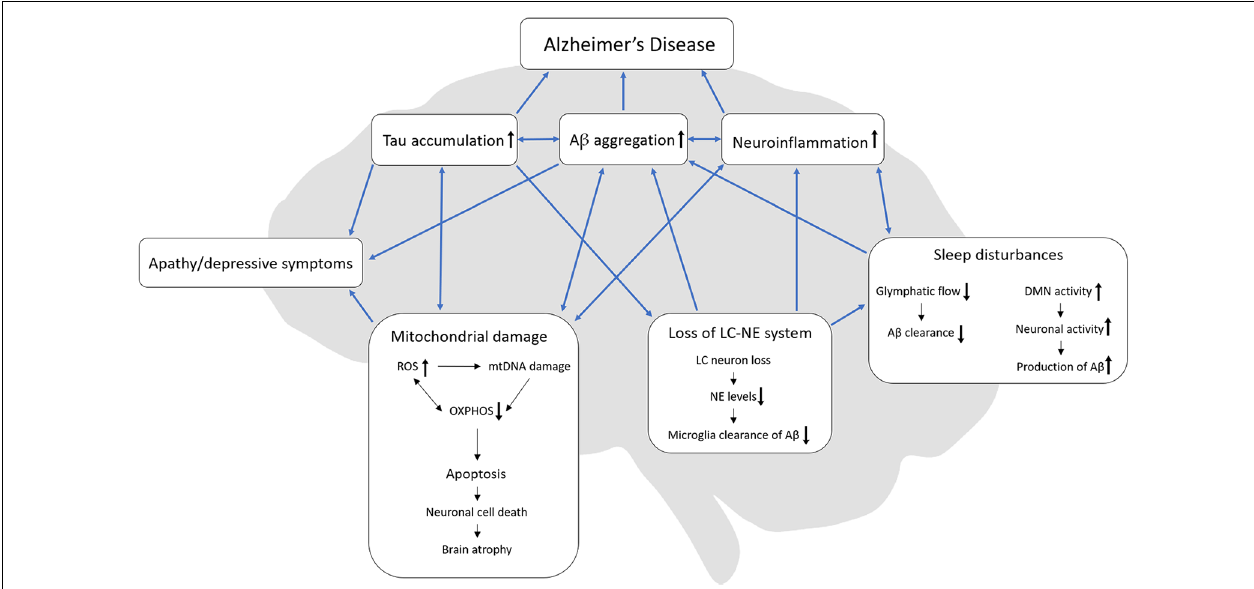
FIGURE 1 | Interactions of AD-related pathologies, apathy, depressive symptoms, and sleep disturbances. We hypothesize, that loss of the LC-NE system might originate from tau accumulation in the LC which in turn can cause sleep disturbances. In turn, sleep disturbances can reduce the glymphatic flow and thereby decrease A β clearance. Also, sleep disturbances might increase the DMN activity due to the lack of sleep which then increases neuronal activity with a resulting increase in A β production. Both loss of the LC-NE system and sleep disturbances can increase neuroinflammation. During mitochondrial damage, ROS increases and can cause damage to both mtDNA and OXPHOS but ineffective OXPHOS can also increase the production of ROS. Mitochondrial damage can ultimately lead to apoptosis, neuronal cell death and lastly brain atrophy, which is present in late-stage AD. Both tau accumulation, A β aggregation and mitochondrial damage can lead to apathy/depressive behavior. AD, Alzheimer’s disease; A β , beta-amyloid; ROS, reactive oxygen species, OXPHOS, oxidative phosphorylation; mtDNA, mitochondrial DNA; LC, locus coeruleus; NE, norepinephrine, DMN, default mode